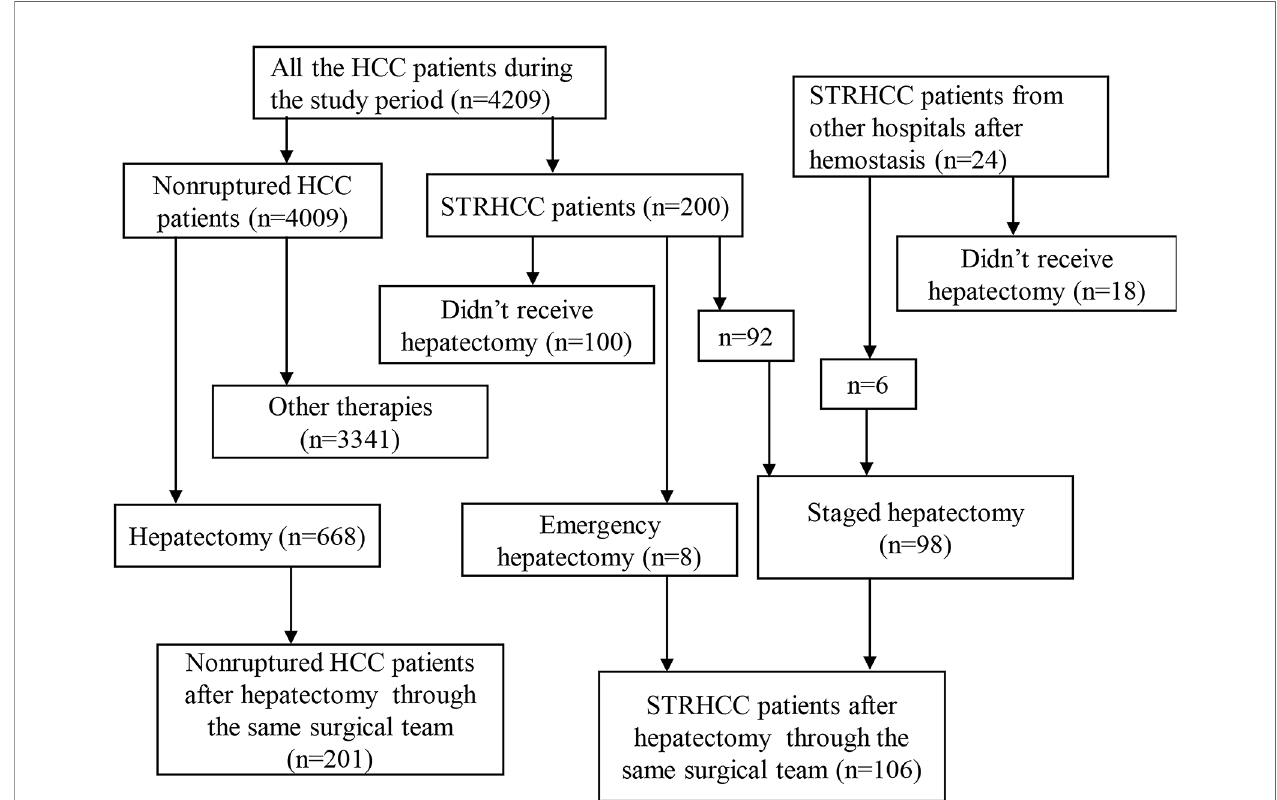
FIGURE 1 | The fl ow chart illustrated the patient selection